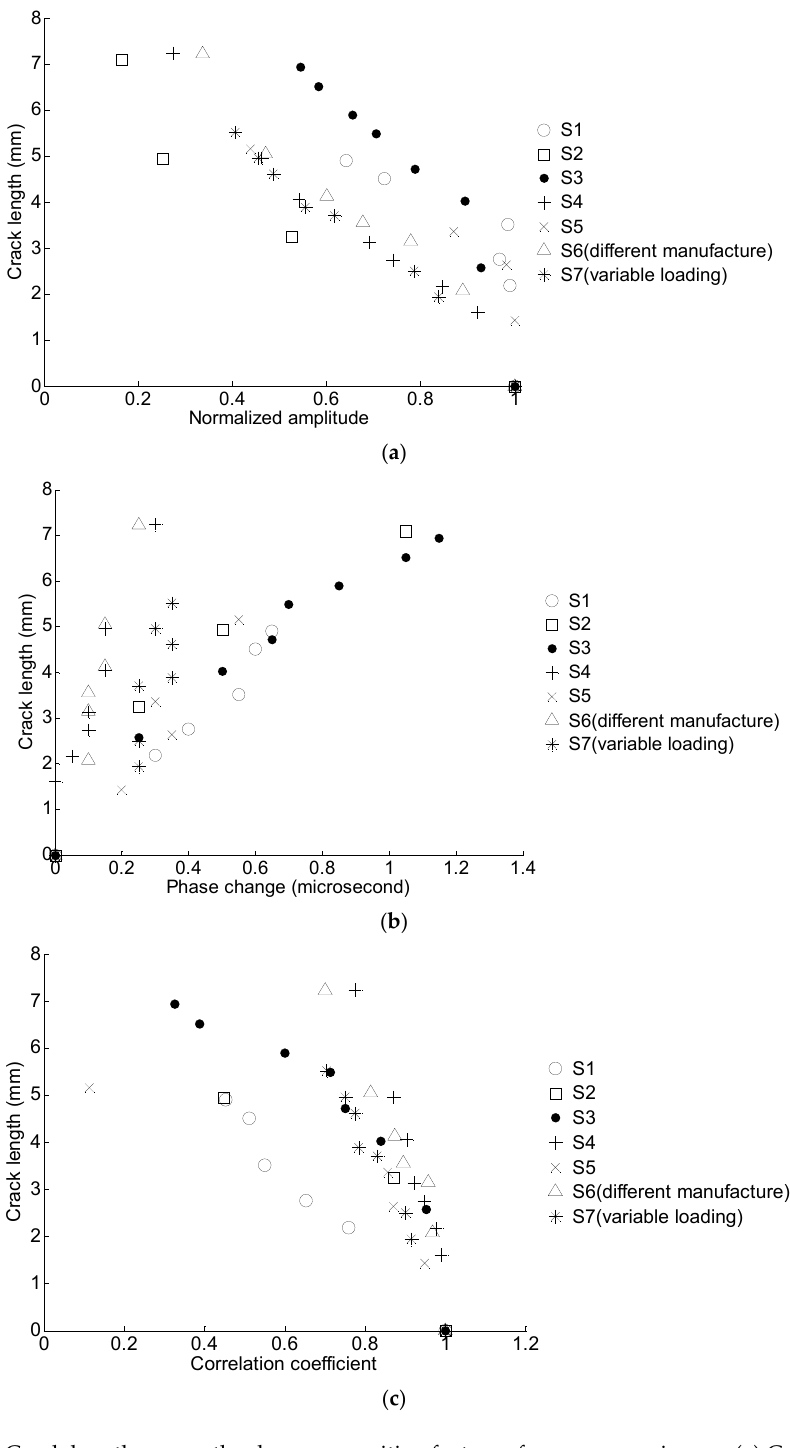
Figure 19. Crack length versus the damage sensitive features for seven specimens. ( a ) Crack length versus the normalized amplitude; ( b ) crack length versus the phase change; ( c ) crack length versus the correlation coefficient.